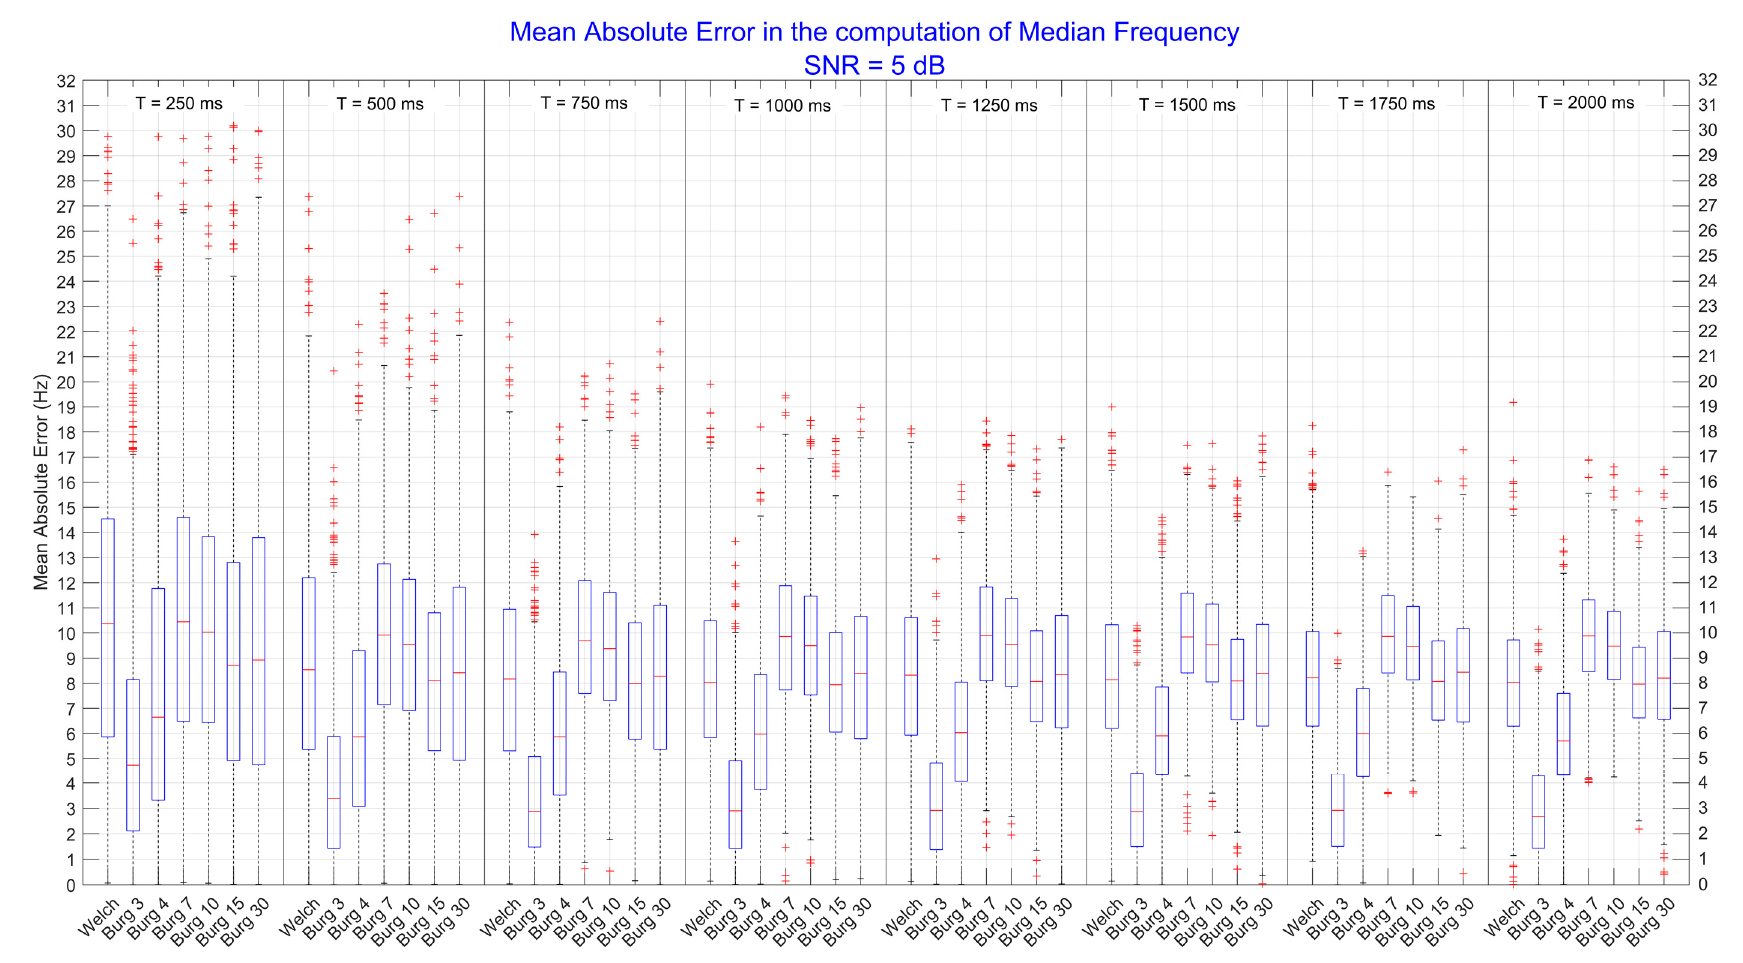
Figure 4. Mean absolute error computed on the median frequency parameters. All values were extracted from power spectral densities that have been estimated by Welch and Burg methods. The figure is divided into 8 subgroups (separated by vertical lines) representing the levels of the duration factor (e.g., T = 250 ms, . . . , and T = 2000 ms). Each represented subgroup was computed when the level of noise was high (SNR equal to 5 dB). The significance level was set at p < 0.05. The mean differences between the 3rd order and all other levels of method were statistically significant ( p < 0.05).